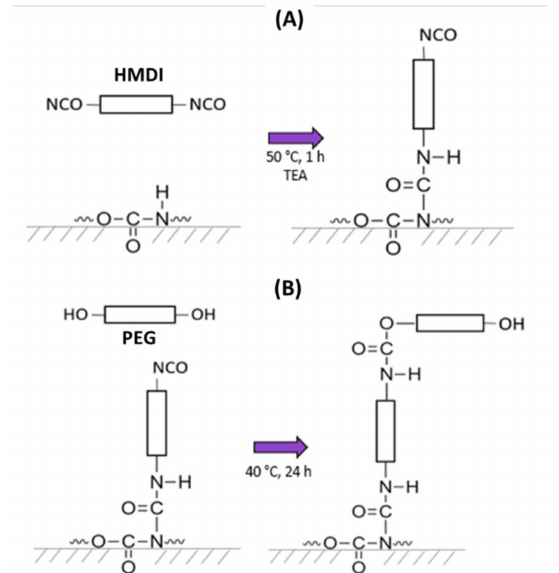
Figure 1. Grafting reaction of PEG onto PU substrates. ( A ): one isocyanate group of HMDI reacts with the secondary amine of the urethane group to yield allophanate linkages, with an isocyanate group remaining unreacted (first step); ( B ): one hydroxyl group from PEG reacts with the free isocyanate group obtained in the previous stage to yield a new urethane linkage (second